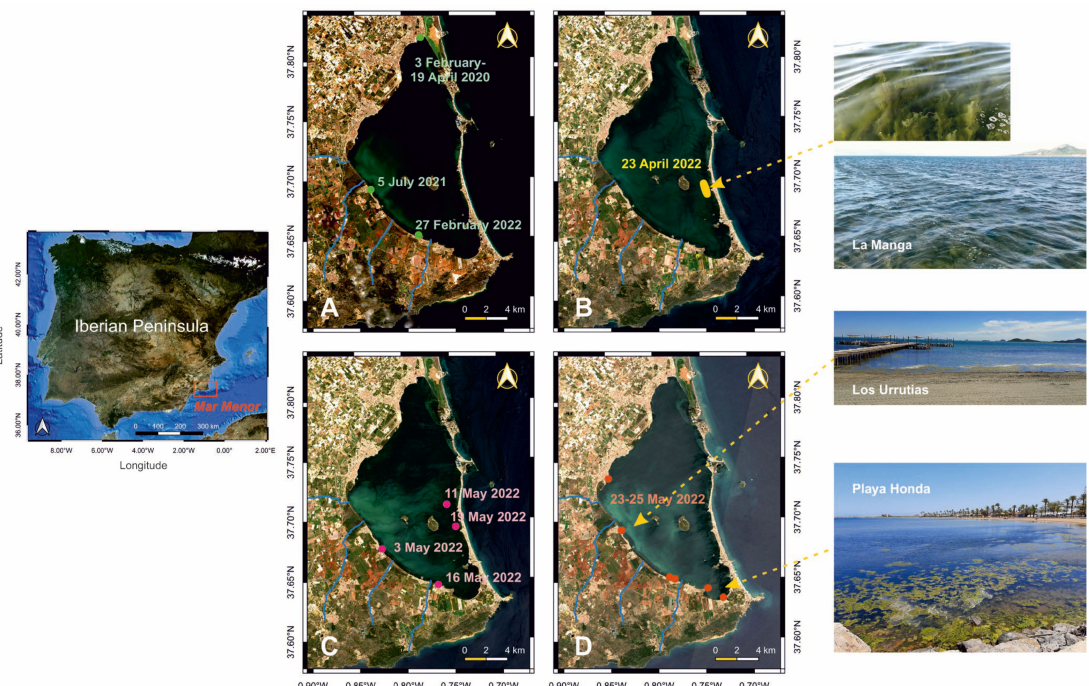
Figure 1. Map of the Iberian Peninsula. The red box delimits the Mar Menor coastal lagoon. In situ locations (including photographs) where macroalgae were observed by the research team on different dates from 2020 to 2022. RGB composite images (true color image Level 2A, 10 m spatial resolution) corresponding to ( A ) 24 February, ( B ) 25 April, ( C ) 10 May, and ( D ) 25 May 2022 are